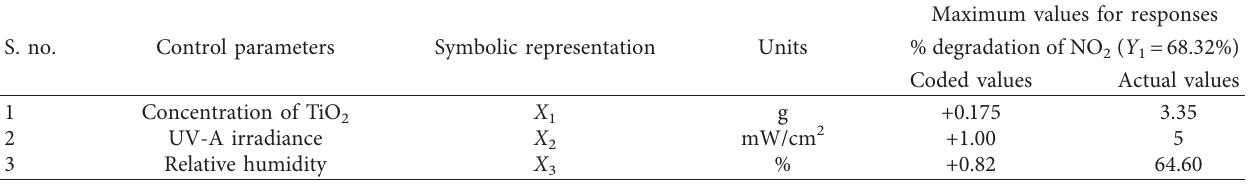
2 -based UV photocatalytic degradation of the pollutants.